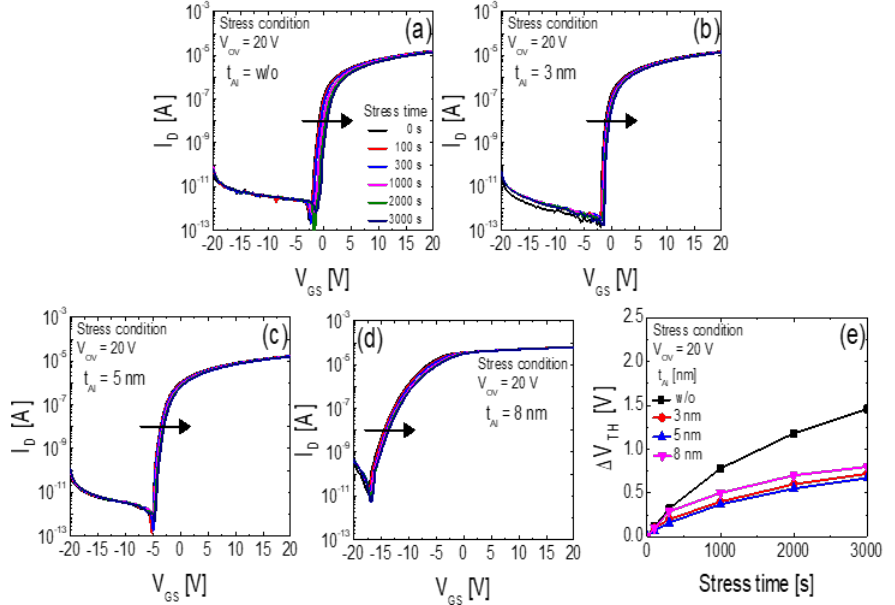
Figure 3. Time dependence of the transfer curves for IGTO TFTs (a) without and with ( b ) 3, ( c ) 5, and ( d ) 8 nm thick Al capping layers, under a positive bias stress (PBS) of V OV = 20 V. ( e ) ∆ V TH obtained from IGTO TFTs without and with 3, 5, and 8 nm thick Al capping layers after each PBS time.